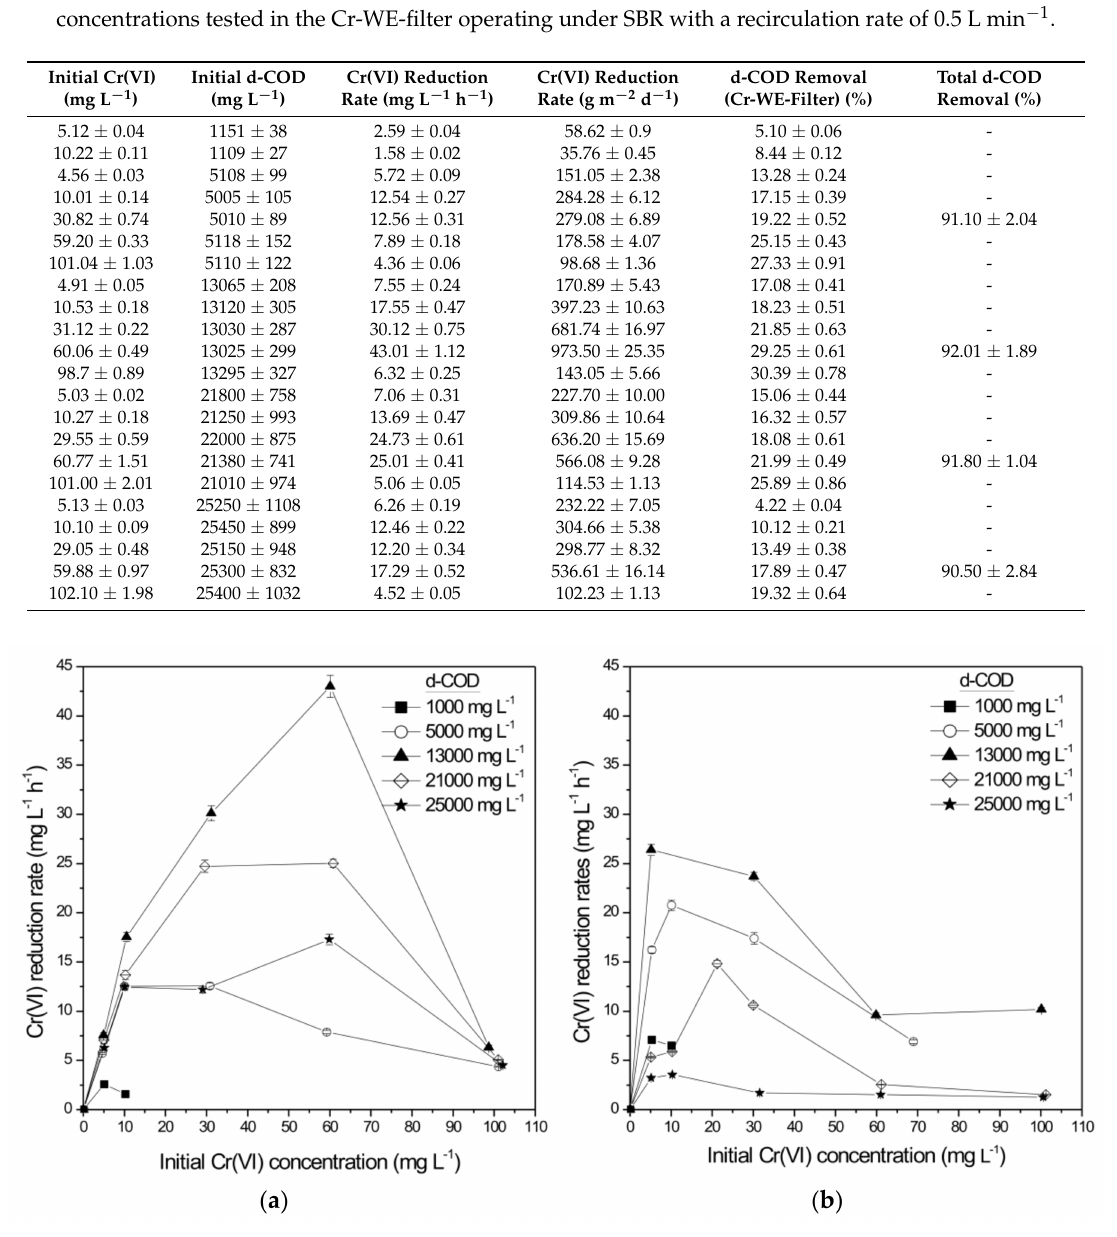
Figure 3. Cr(VI) reduction rates in the Cr-WE-filter operating under SBR with recirculation mode for various initial Cr(VI) and d-COD concentrations and two different recirculation rates: ( a ) 0.5 L min − 1 and ( b ) 1.0 L min − 1